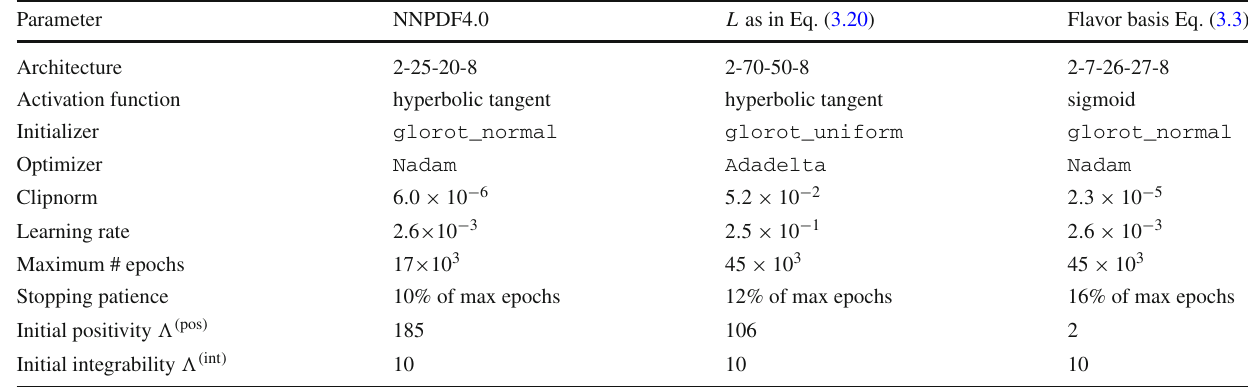
tion basis. We also show a configuration selected using the alternative hyperoptimization loss Eq. (3.20) (center) and the hyperparameter con- figuration employed to perform fits in the flavor basis, Eq. (3.3)